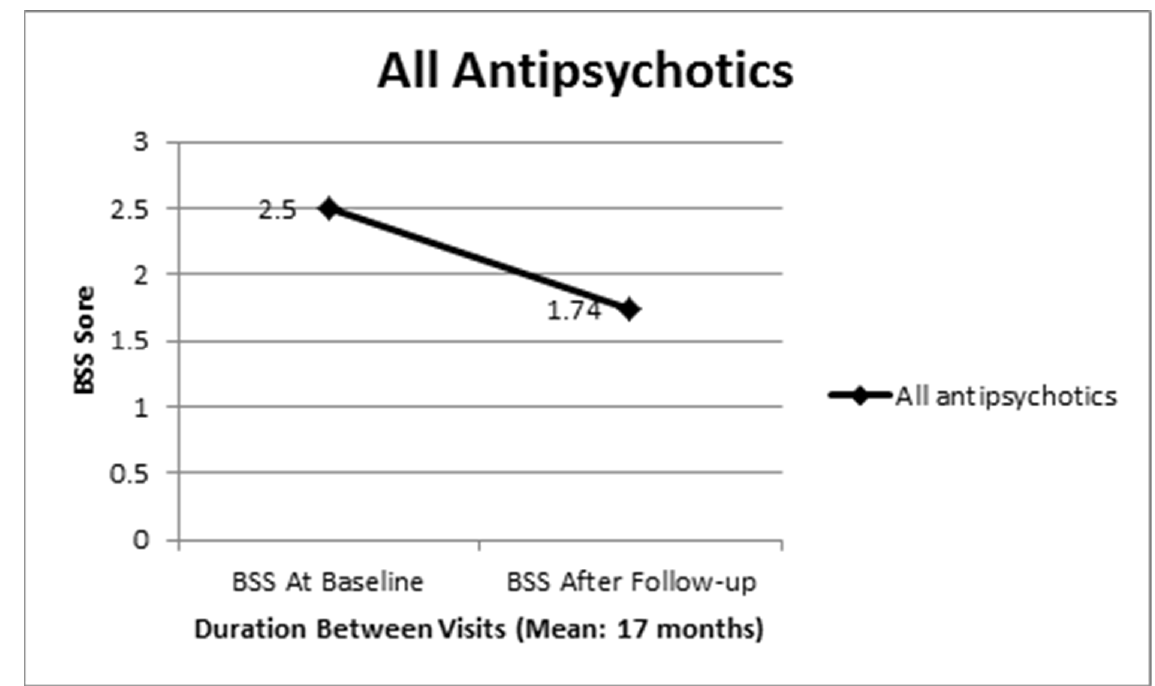
Figure 1. Beck Scale for Suicidal Ideation (BSS) score changes at follow-up.